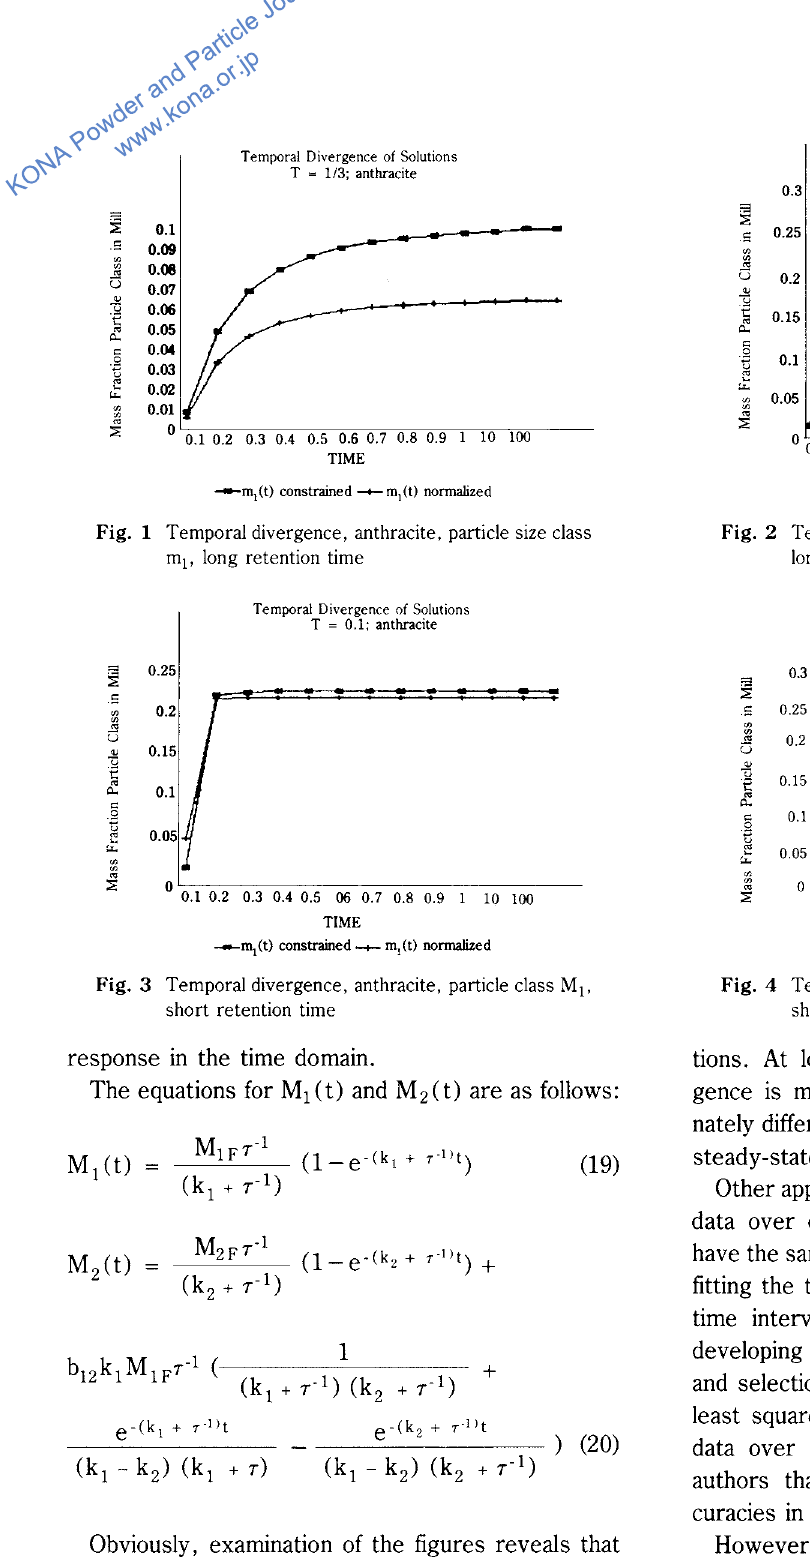
Fig. 2 Temporal divergence, anthracite, particle class M 2, long retention time